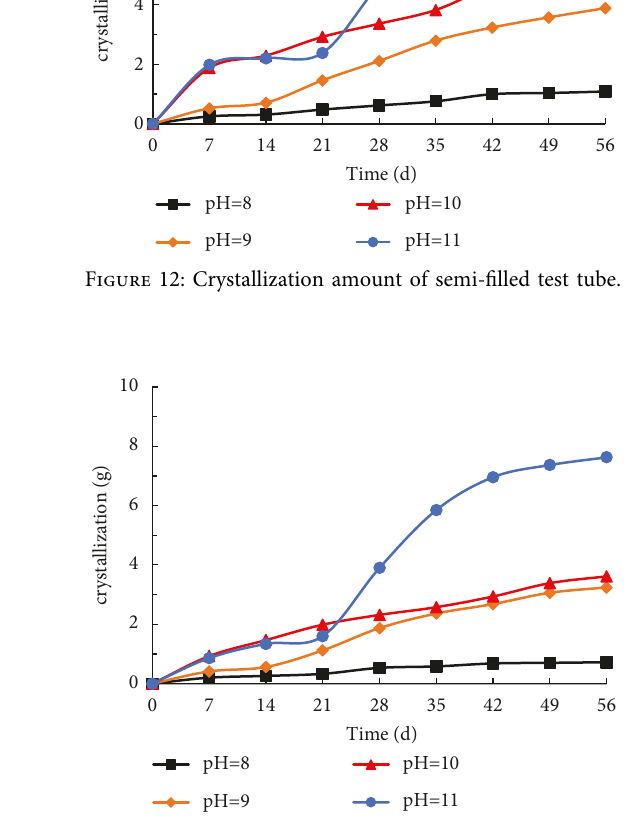
Figure 13: Crystallization amount of full-filled test